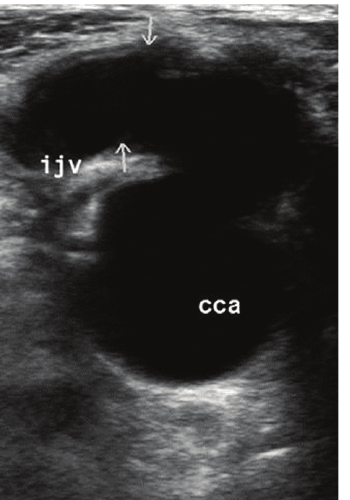
Figure 1: Ultrasound demonstrating fistula connecting right CCA to the right